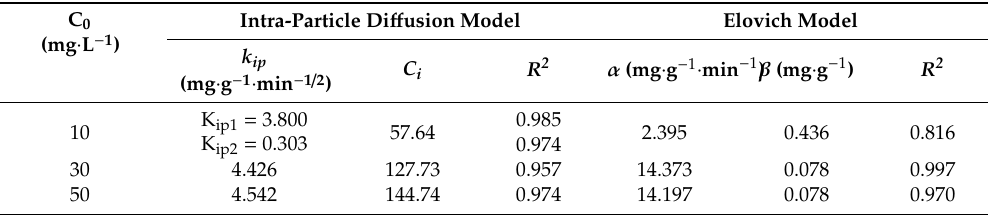
Table 3. Intra-particle di ff usion model and Elovich model from removal of MB by